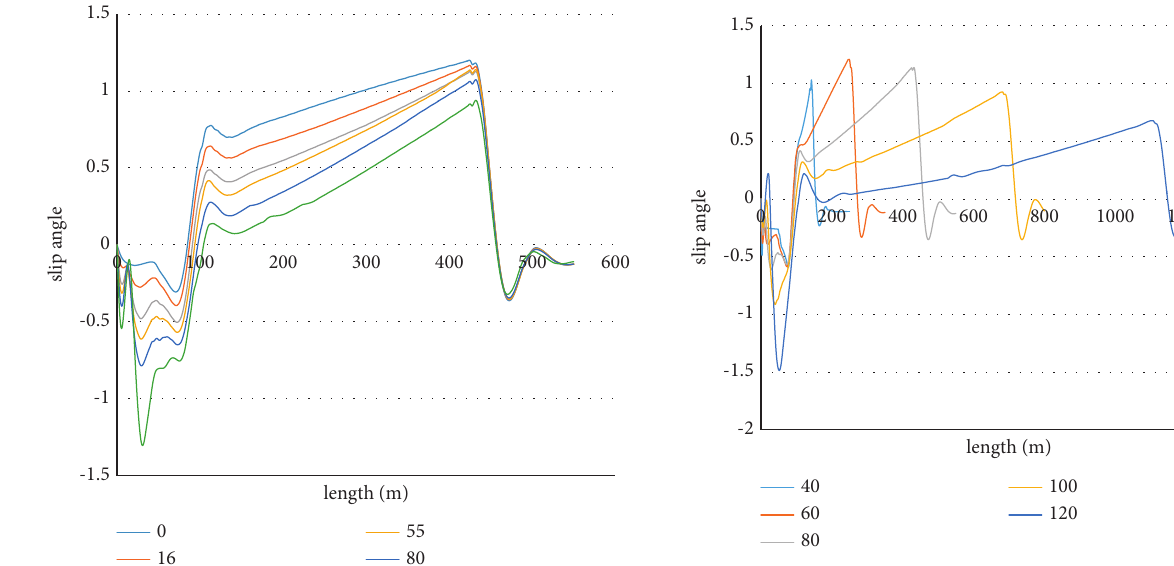
Figure 24: Comparison of slip angle along the route at different vehicle speeds. Table 6: Percentage of changes in slip angle on slope state of − 4% and wind speed of 16